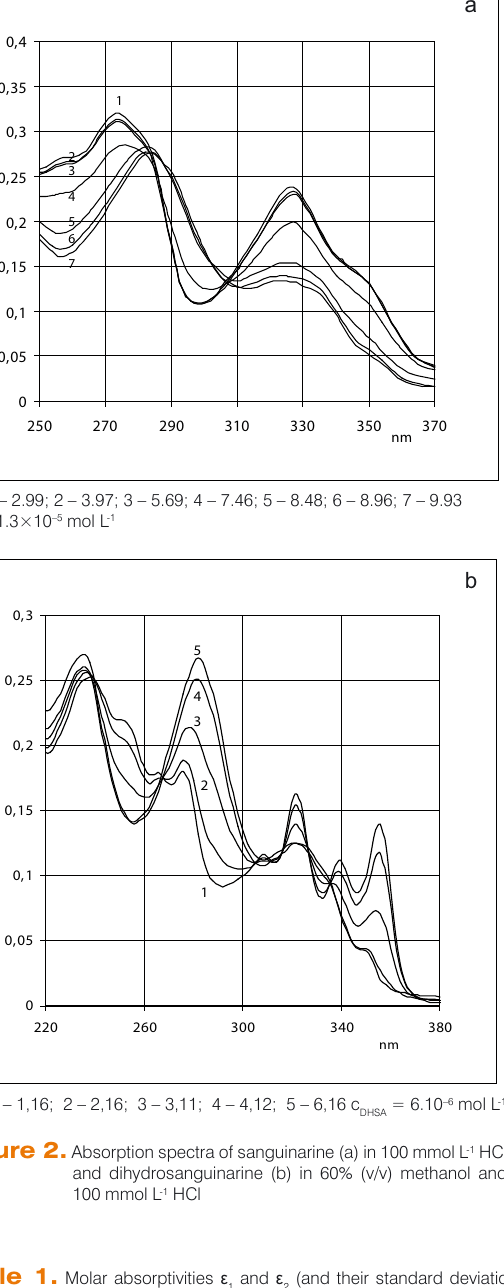
and ε (and their standard deviations) of cationic form ( ε 1 2